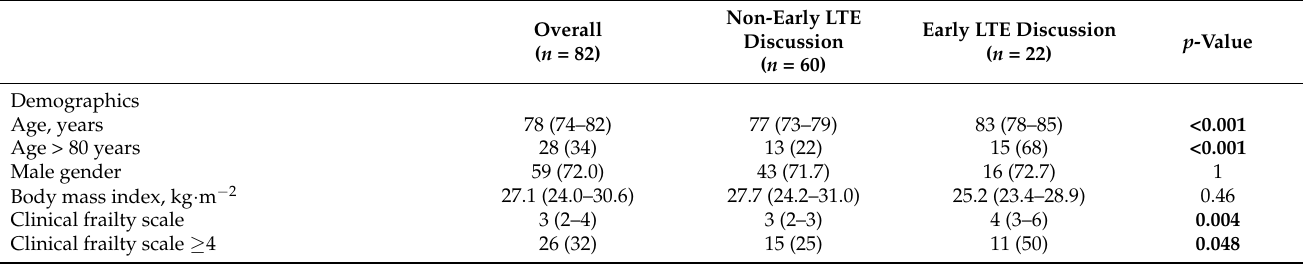
Table 1. Characteristics of 82 critically ill COVID-19 elderly patients on intensive care unit admission according to the early versus non-early discussion of limitation of therapeutic